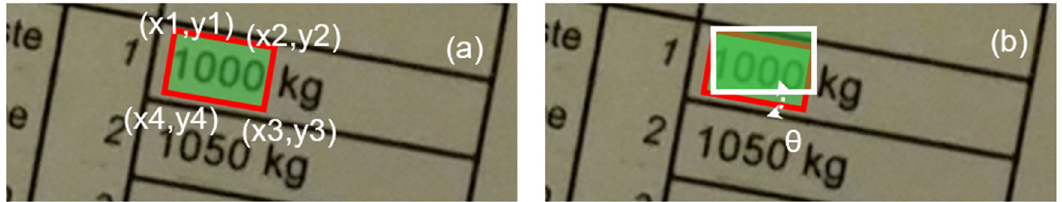
Figure 2. The two different methods to define the text “boundary box”.